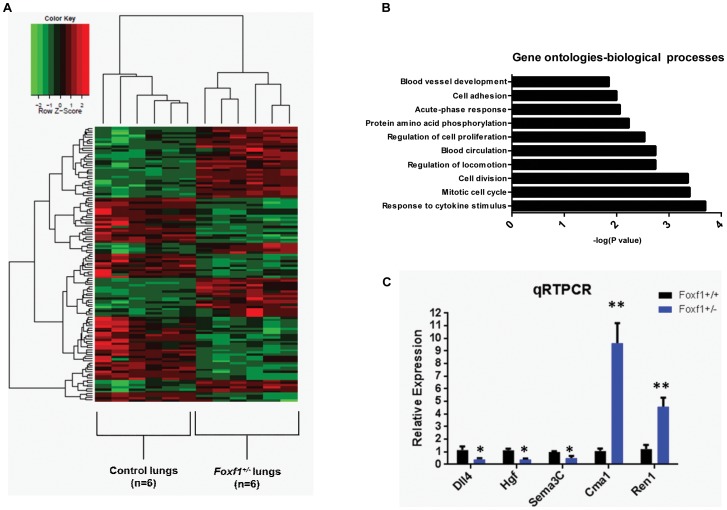

Foxf1
+/− mouse lung microarray analysis: heat map, clustering, DAVID analysis, and qRT-PCR validation.(A) Heat map for genes differentially expressed (fdr <0.05, fold change >/ =  2 or </ =  − 2) between Foxf1
+/− lungs (n = 6) and littermate control lungs (n = 6); Decreased gene expression is shown in green and increased gene expression is shown in red; Foxf1
+/− lung samples and wildtype lung samples cluster as two separate groups. (B) Top significant gene ontology (biological processes) terms associated with deregulated genes from DAVID analysis. (C) qRT-PCR validation for down-regulated genes (Sema3C, Dll4, and Hgf) and up-regulated genes (Cma1 and Ren1); n = 6 for each group; * =  p value <0.05; ** = p value <0.001.